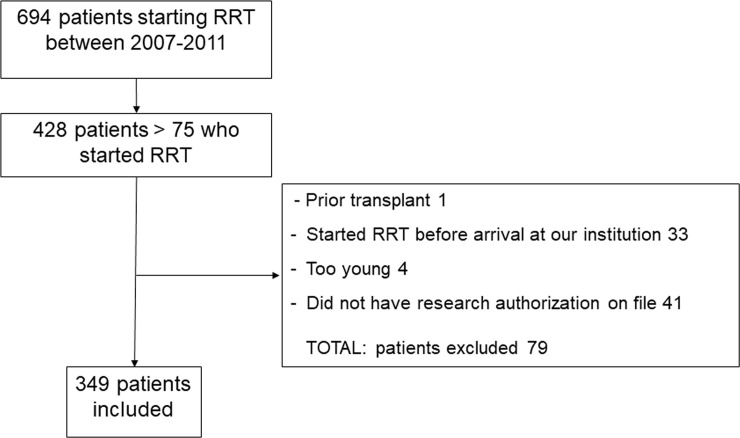
Flowchart of cohort development.